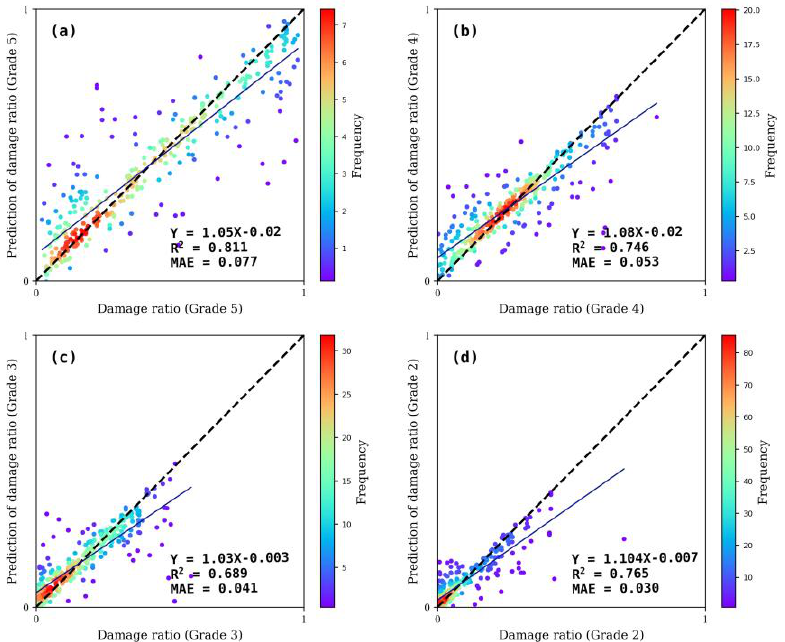
Figure 10. Evaluation of the assessment results of the best-performing (considering building attributes) regression model for different damage grades on test data. Subplots ( a – d ) represent evaluation of the best-performing model for damage grades 5-2, respectively.